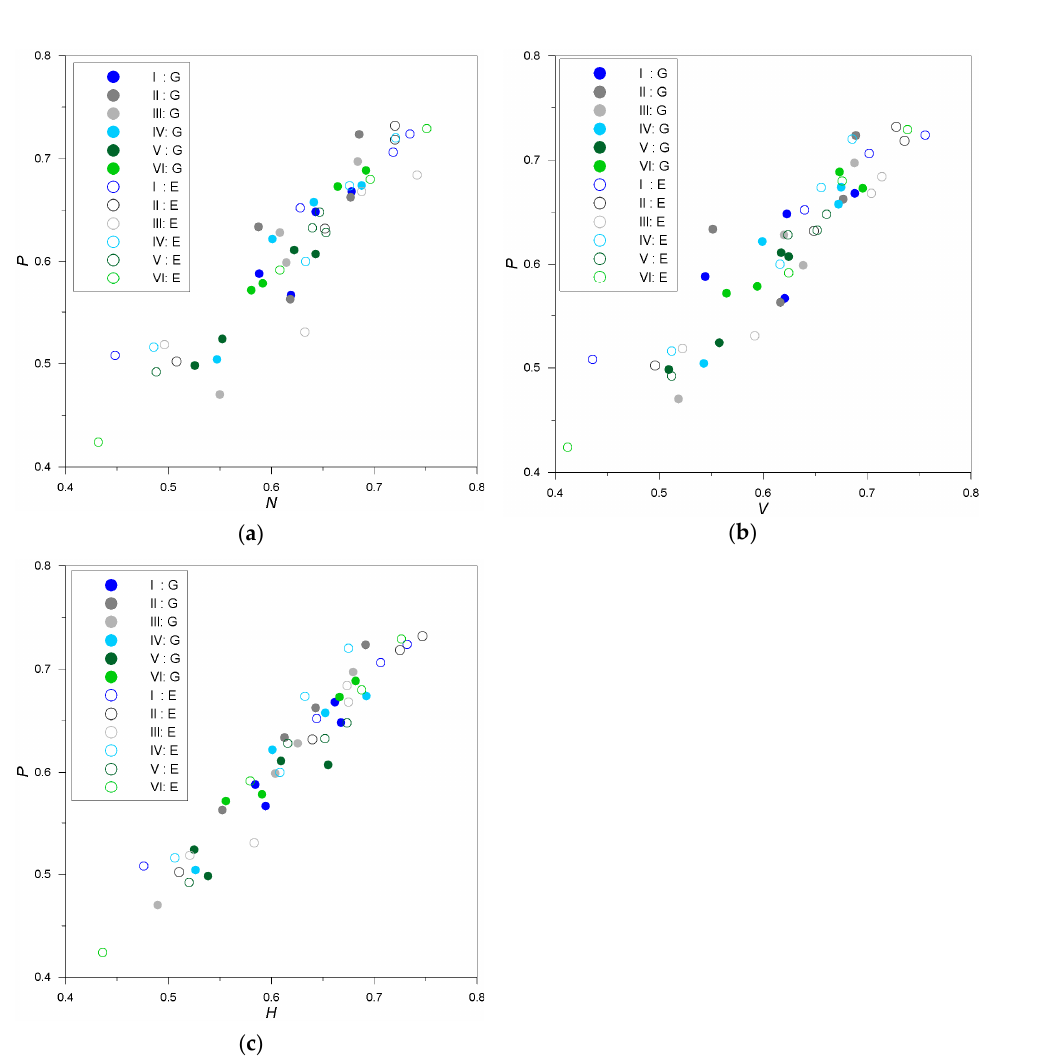
Figure 3. Relationship between preference P and cognitive indicators (naturalness N , vividness V , and harmony H ) for the expert (E) and general public (G) groups for different image sets (I, II, III, IV, V, and VI). ( a ) Preference P and naturalness N ( r = 0.908 at p < 0.001 when two groups, G and E, were analyzed together). ( b ) Preference P and vividness V ( r = 0.895 at p < 0.001 when two groups, G and E, were analyzed together). ( c ) Preference P and harmony H ( r = 0.966 at p < 0.001 when two groups, G and E, were analyzed together).